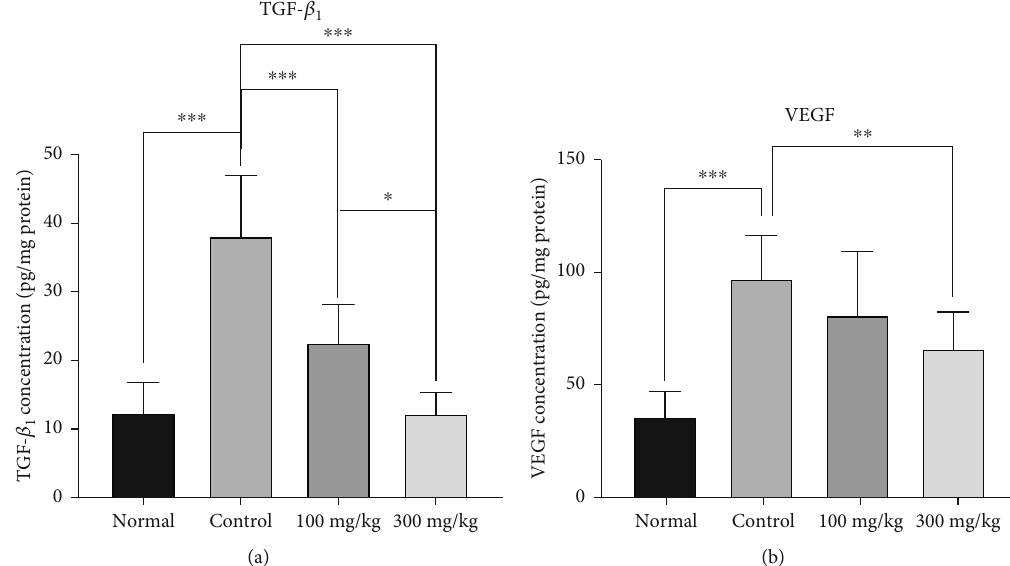
Figure 6: The e ff ects of di ff erent doses of PO on the peritoneal lavage levels of (a) TGF- β and (b) VEGF; data were presented as mean ± SD ( n = 8 for all groups except normal as 6). ∗ P < 0 : 05 , ∗∗ P < 0 : 01 , and ∗∗∗ P < 0 : 001 .